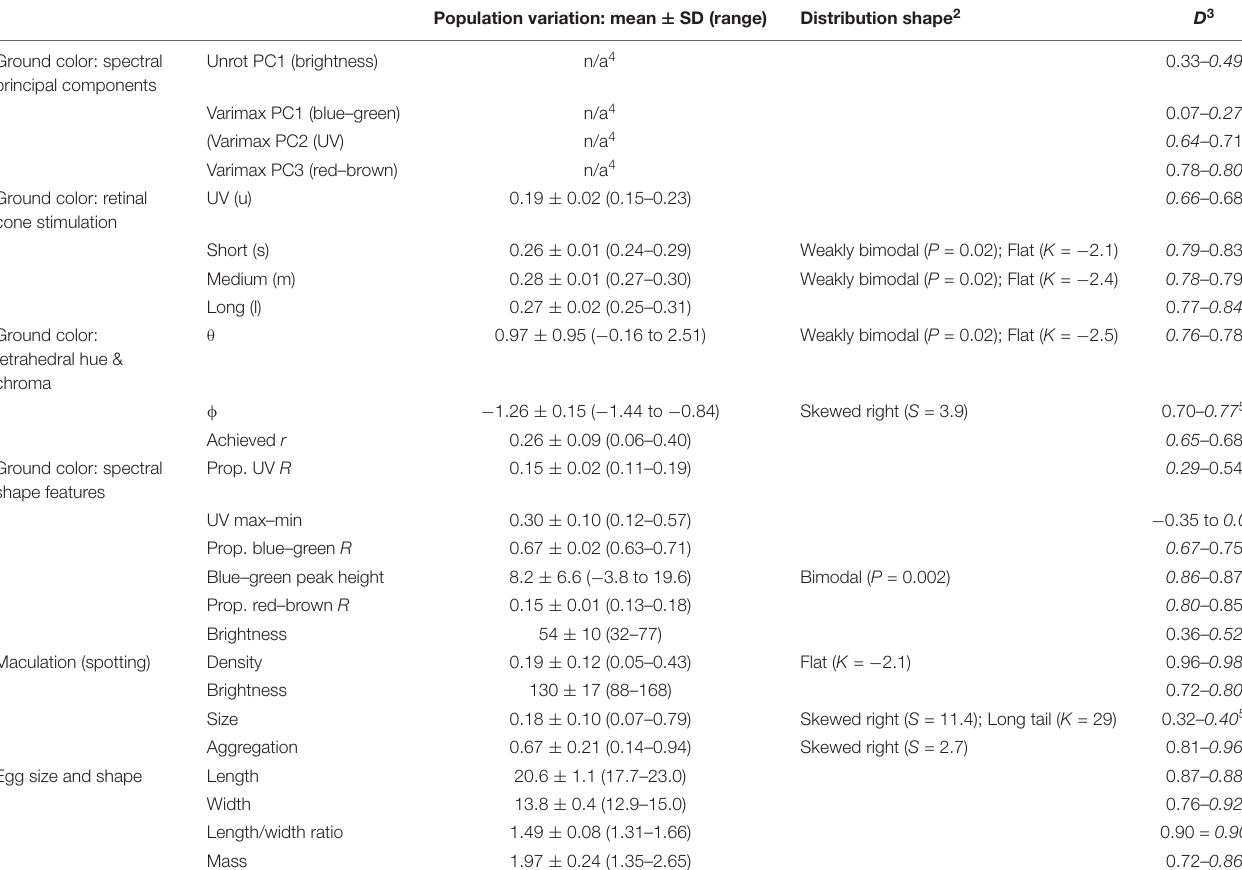
TABLE 1 | Statistics relating to appearance of Rüppell’s weaver ( Ploceus galbula ) eggs and the structure of their variation 1 . Population variation: mean ± SD (range) Distribution shape 2 D